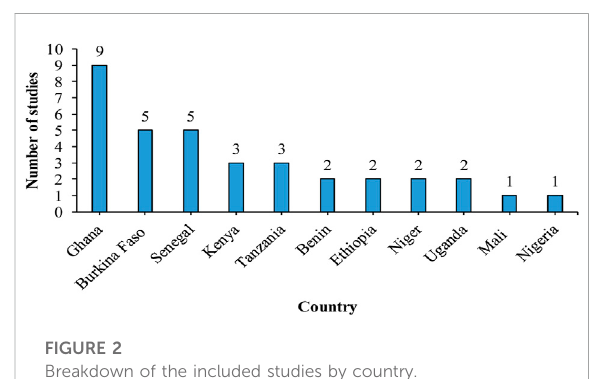
FIGURE 2 Breakdown of the included studies by